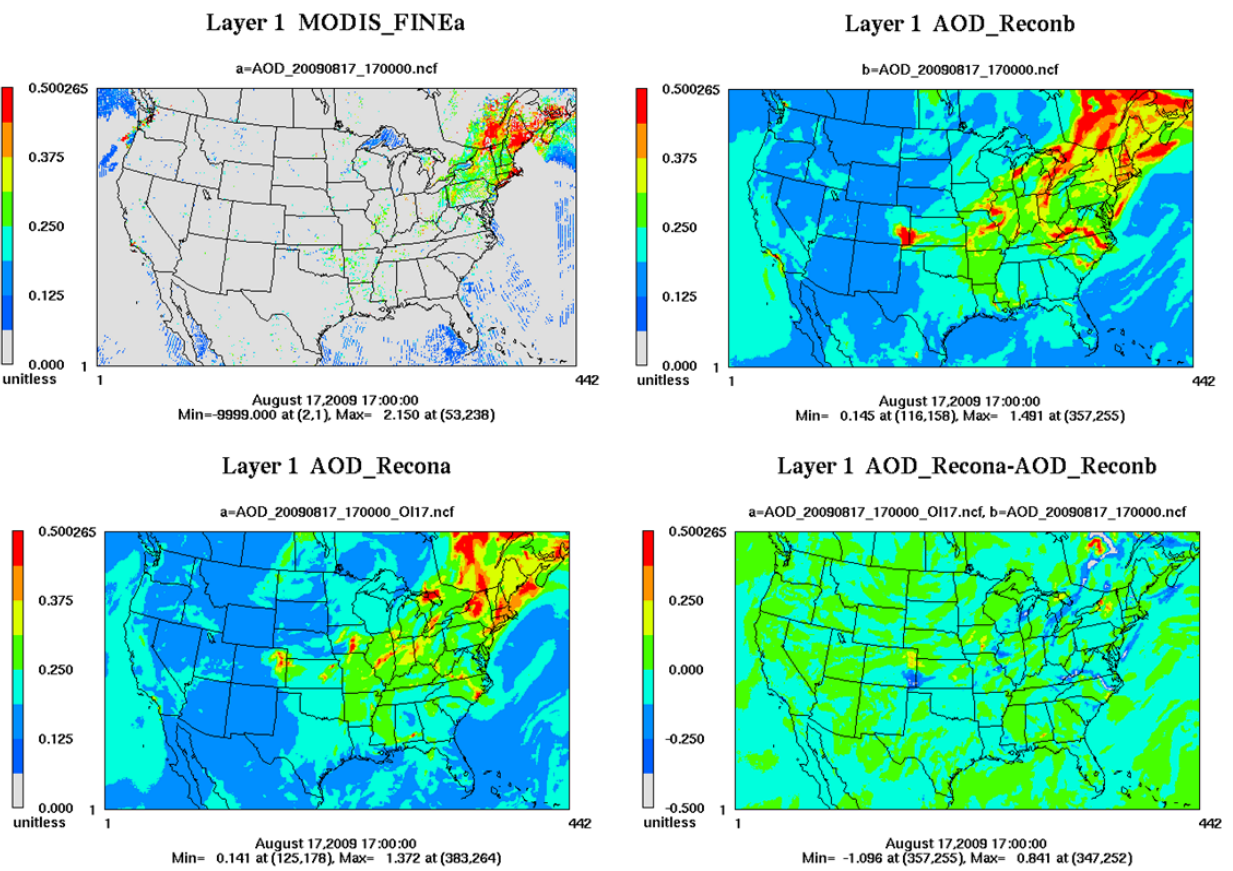
Figure 4. MODIS AOD (fine mode) and CMAQ reconstructed AOD. AOD-Recona and AOD-Reconb are calculated before and after assimilation. The